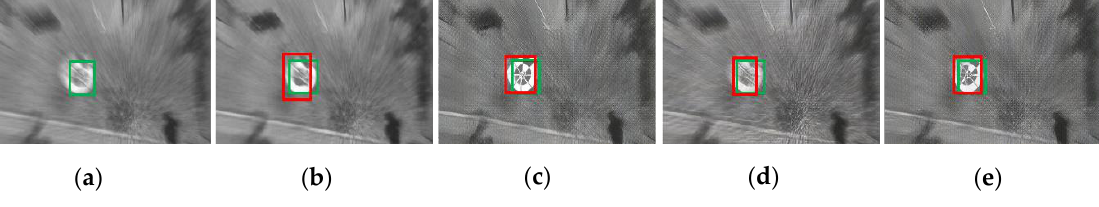
Figure 16. Examples of detection results on RMBD-DB1. The green boxes represent the ground truth bounding boxes and the red boxes represent the boxes detected by ( a ) YOLOv2, ( b ) DeepDeblur and YOLOv2, ( c ) a combination of DeblurGAN and YOLOv2, ( d ) a combination of DeblurGAN (MobileNet) and YOLOv2, and ( e ) a combination of SlimDeblurGAN and YOLOv2 (ours).